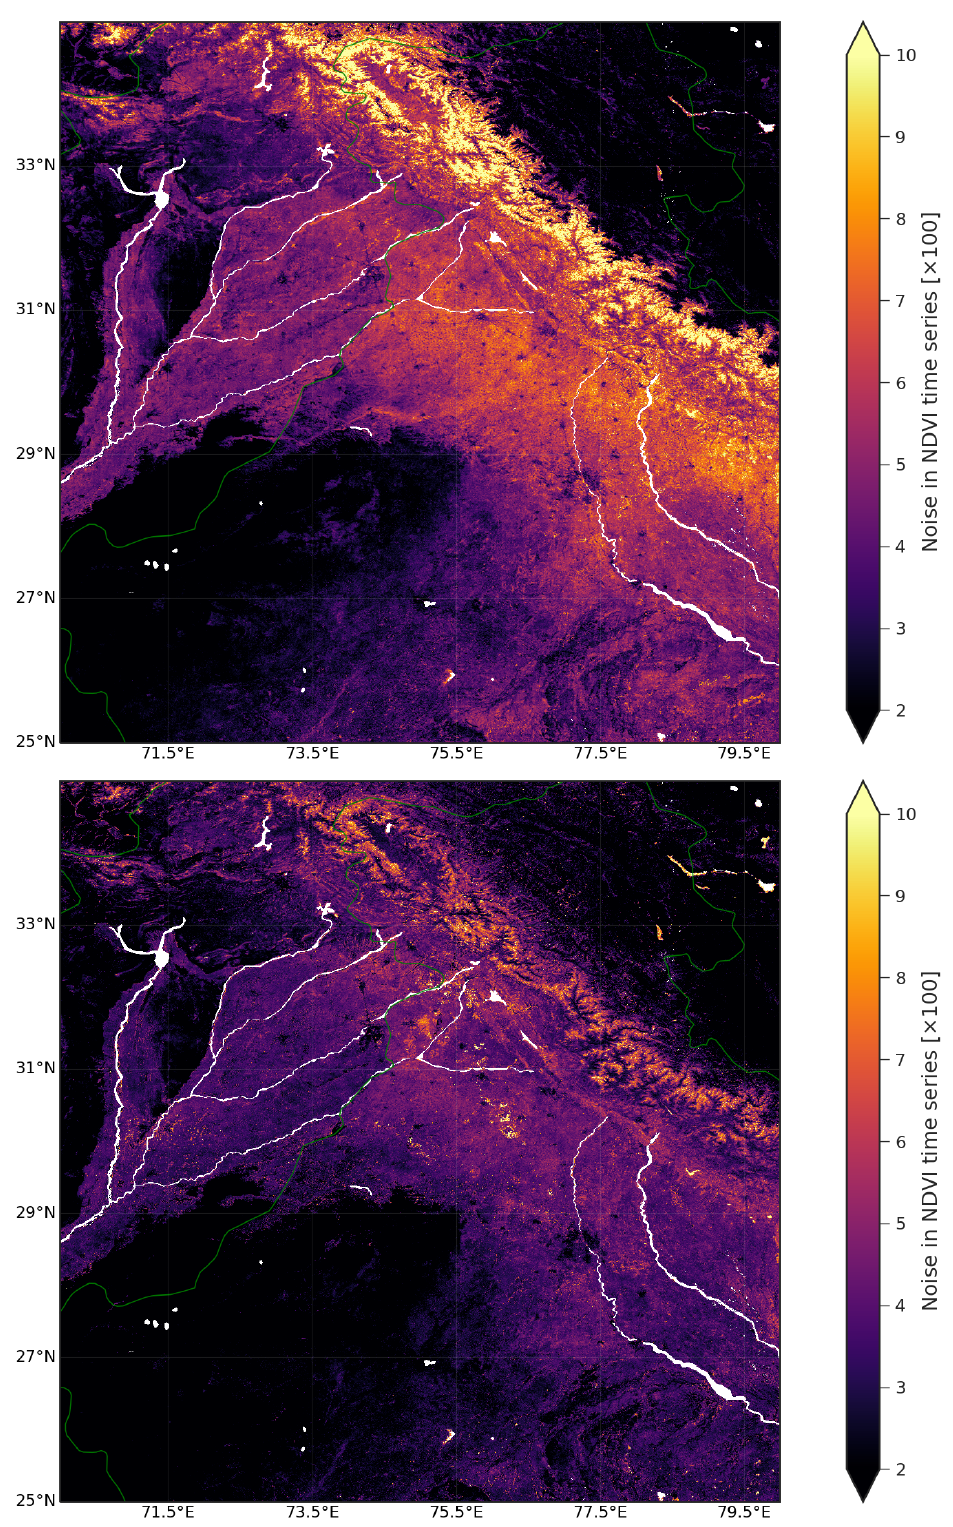
Figure 9. Statistical noise in MVC NDVI ( top-panel ) and BRDF-adjusted NDVI ( bottom-panel ) Time-Series for a subregion in Northern India. The noise levels and country borders are color coded in the same fashion as in Figure 7. Figure 8 illustrates the artefacts for a subregion of Western Europe where the top and NDVI time-series, respectively. The noise levels for MVC NDVI time-series display a dependence on the latitude. In particular, the MVC NDVI compositing strategy favors satellite observations within a reduced range of viewing zenith angles. Therefore, this